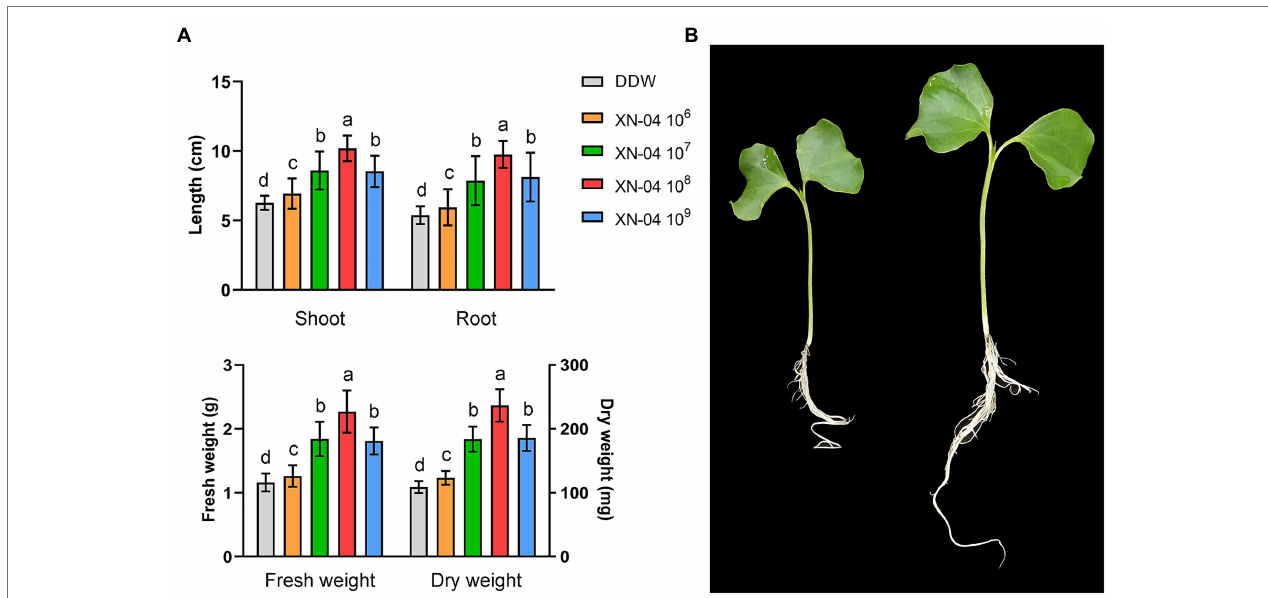
FIGURE 2 | Cotton plants growth-promoting assay. (A) Data for shoot length, root length, fresh weight, and dry weight of cotton plants 14 days after XN-04 inoculation. Data are mean ± SD ( n = 5). Different lowercase letters indicate a significant difference at p < 0.05 level by Duncan’s new multiple range test. (B) Overall plant